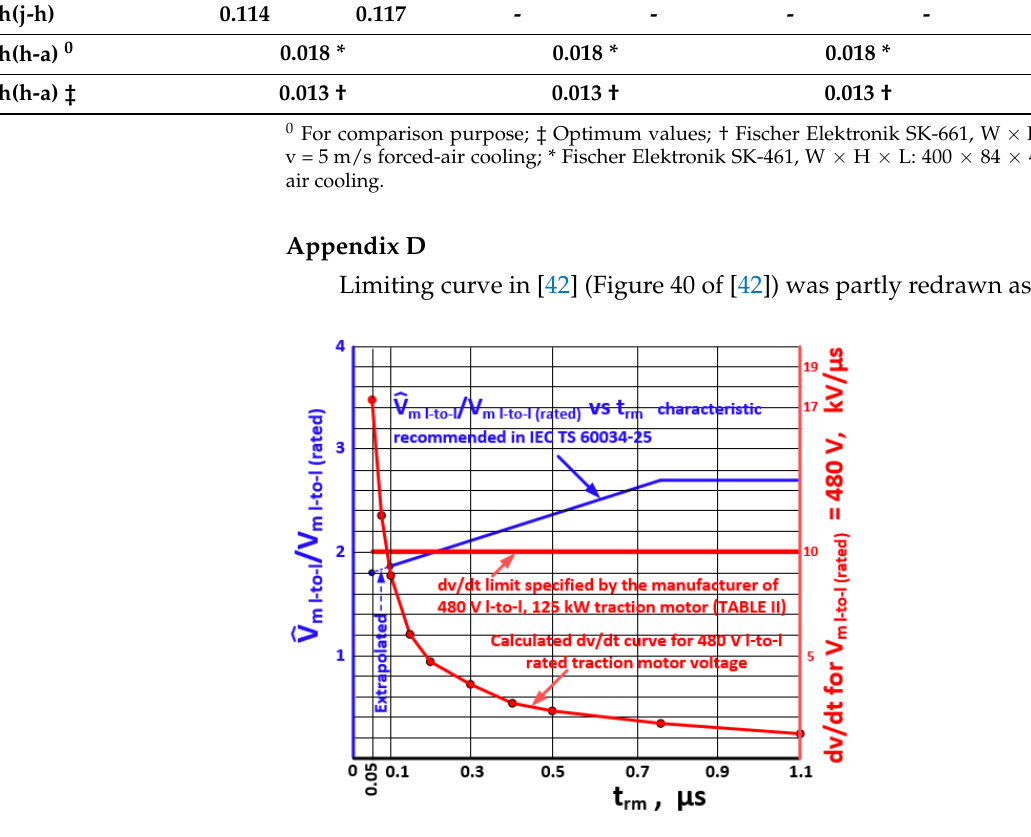
Figure A3. Limiting curve in [42] (Figure 40 of [42]) and corresponding dv/dt curve for 480 V l-to-l- rated traction motor voltage as a function of the rise time, t rm , of the voltage pulse at the electrical machine terminals.